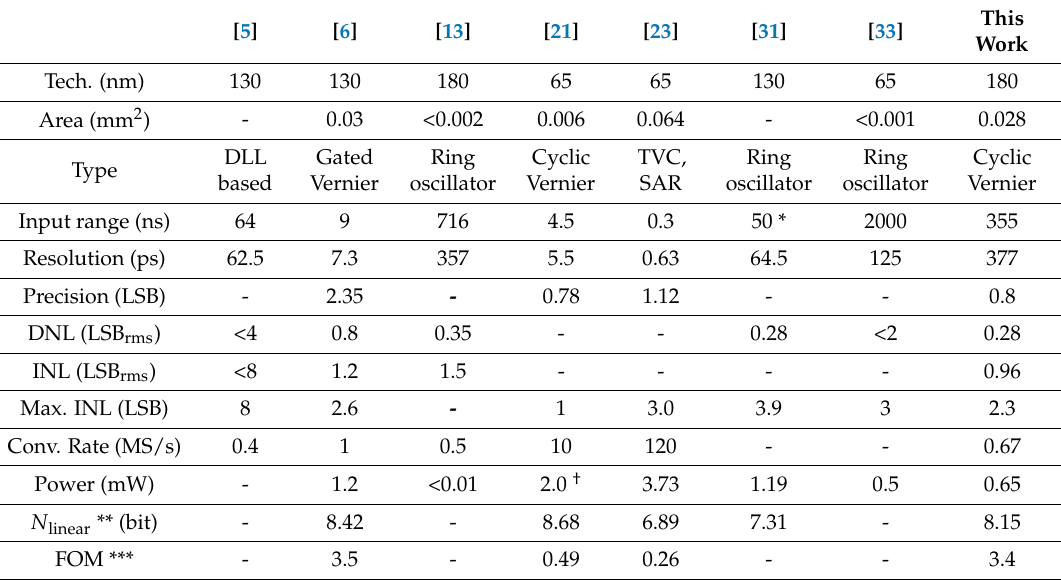
Table 1. Performance summary and